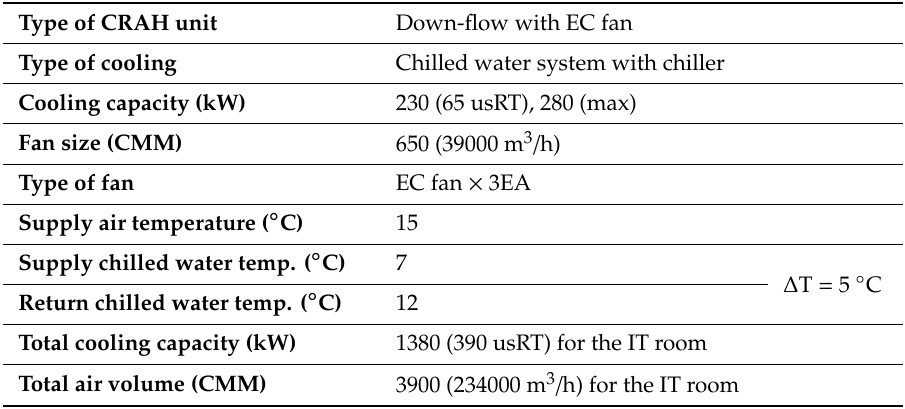
Table 2. Detailed specification of CRAH unit for CFD simulation.